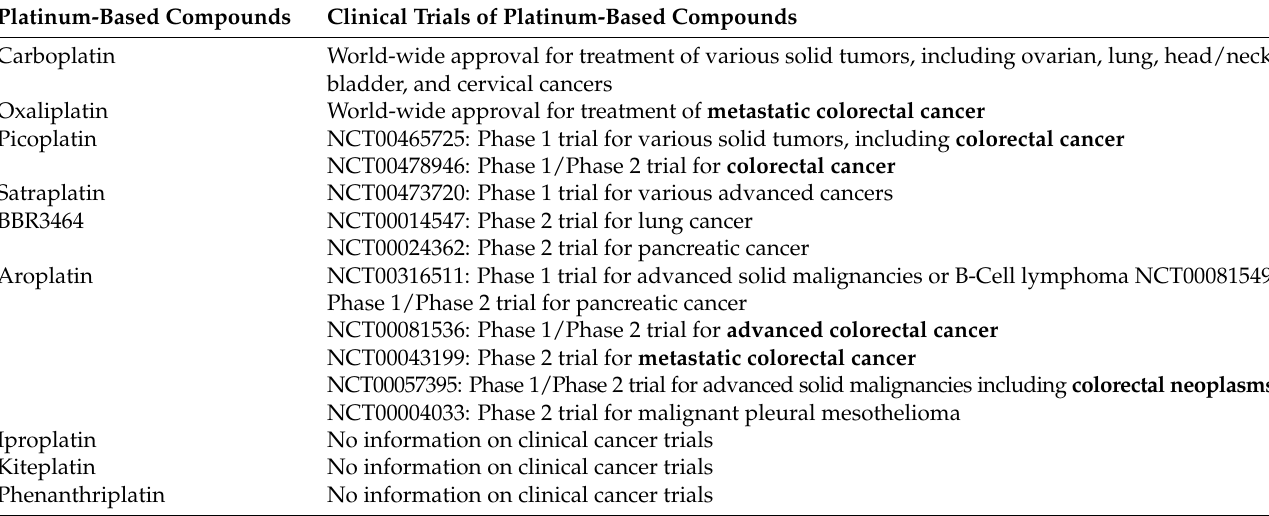
Table 1. Platinum-based compounds and examples of clinical trials with platinum-based compounds. NCT#: Clinical trial ID. Platinum-Based Compounds Clinical Trials of Platinum-Based